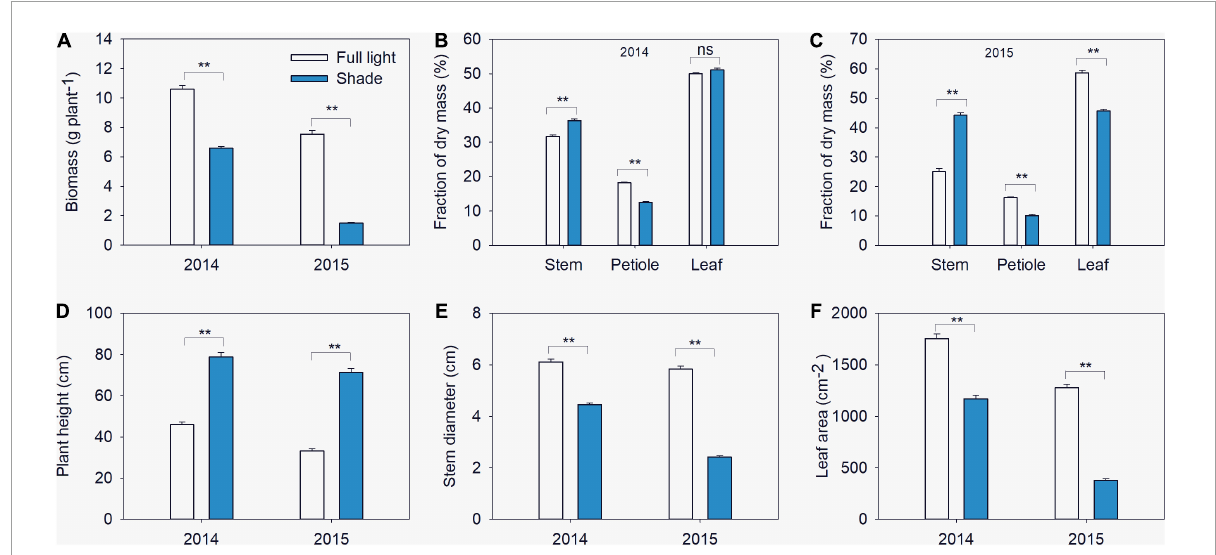
FIGURE2 Biomass (A) , fractions of dry mass in stem, petiole and leaf (B,C) , plant height (D) , stem diameter (E) and leaf area (F) of different soybean varieties grown under shade and the control conditions in 2014–2015. Traits were expressed as mean ± standard errors from 20 cultivars in 2014 and 14 cultivars in 2015. ** represent significant difference at 0.01 level.